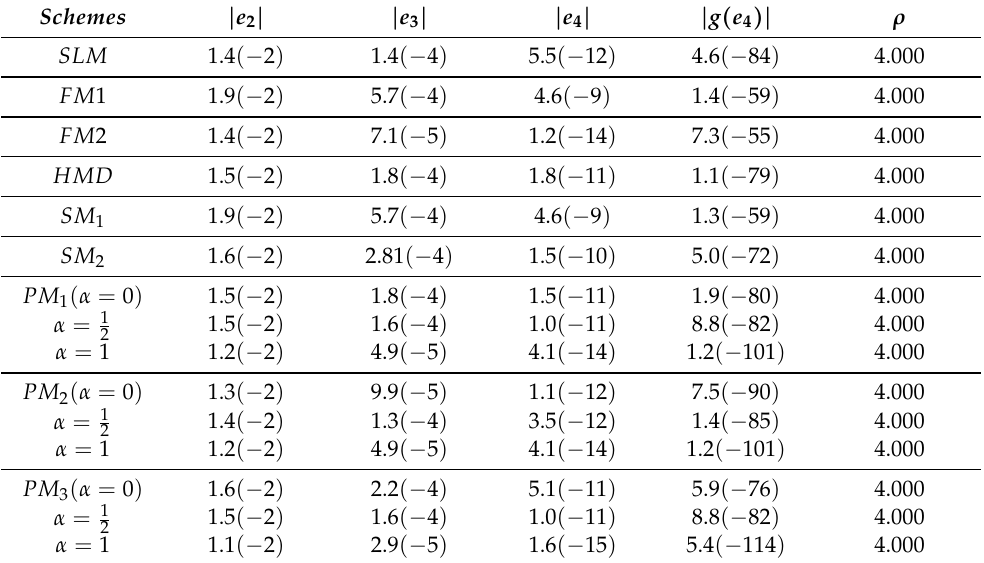
Table 1. Numerical results of Example